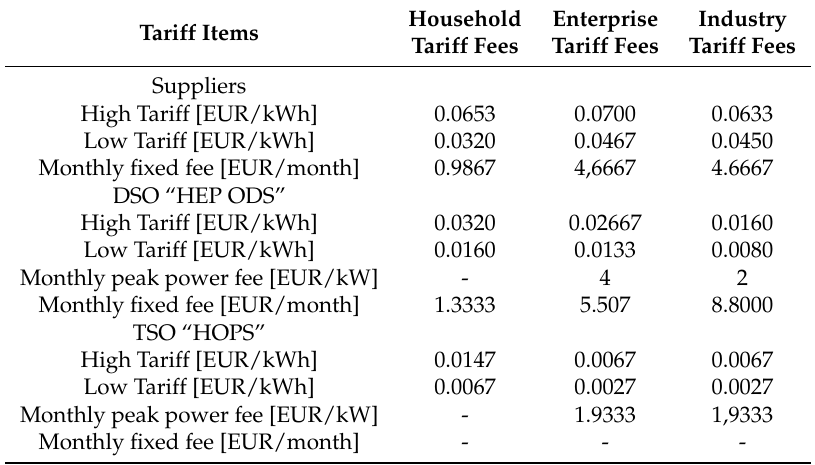
Table 9. Tariffs in Croatia: Supplier, DSO, and